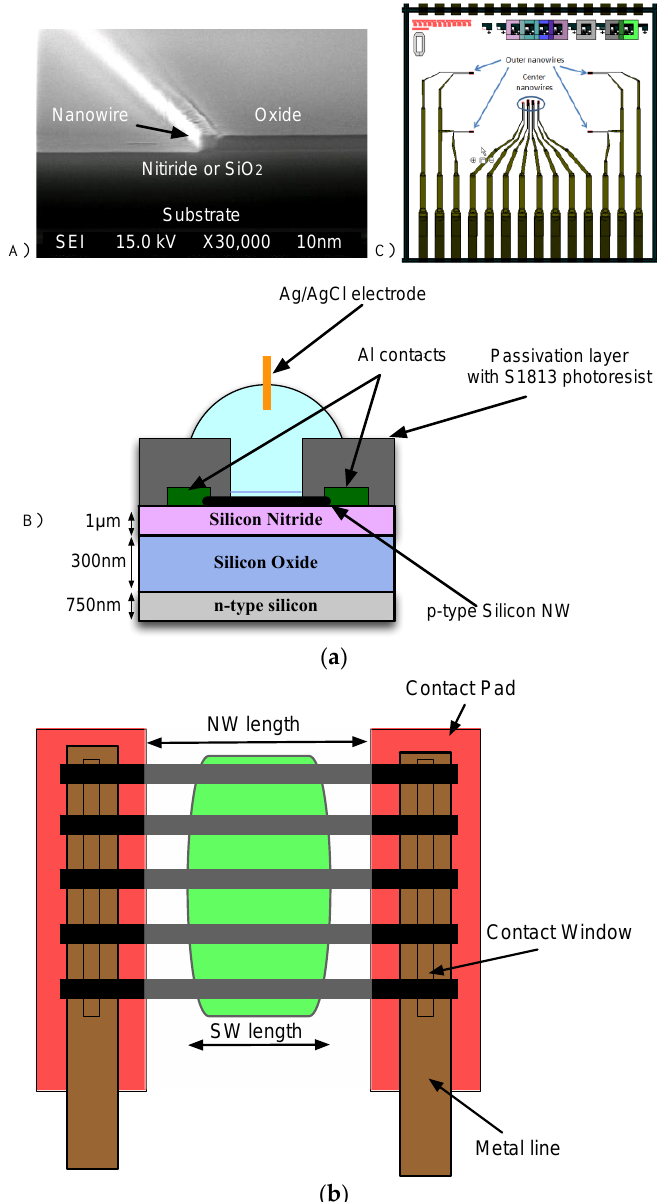
Figure 1. ( a ) Cross section of the nanowire: ( A ) SEM image of a fabricated polysilicon nanowire; ( B ) cross sectional diagram showing the different layers; ( C ) Layout of a NW chip showing connection pads compatible with standard commercial connectors; ( b ) Top view of a single NW device. Different numbers of nanowires (from 10 to 320) are connected in parallel depending on the nanowire set. The green area is the sensing window. The remainder of chip is covered with a layer of photoresist. The red area is the source/drain pads.